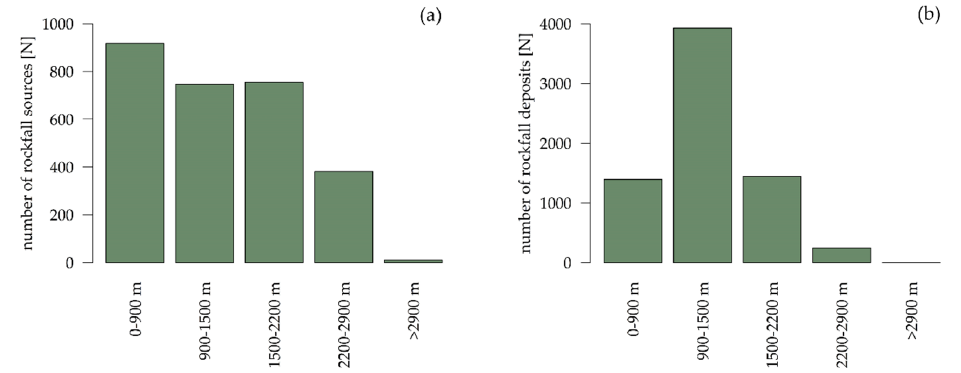
Figure 9. Statistics for ( a ) rockfall sources and ( b ) rockfall deposits, located within each vegetation and altitudinal zone in the Alpine Space. altitudinal zone in the Alpine Space.